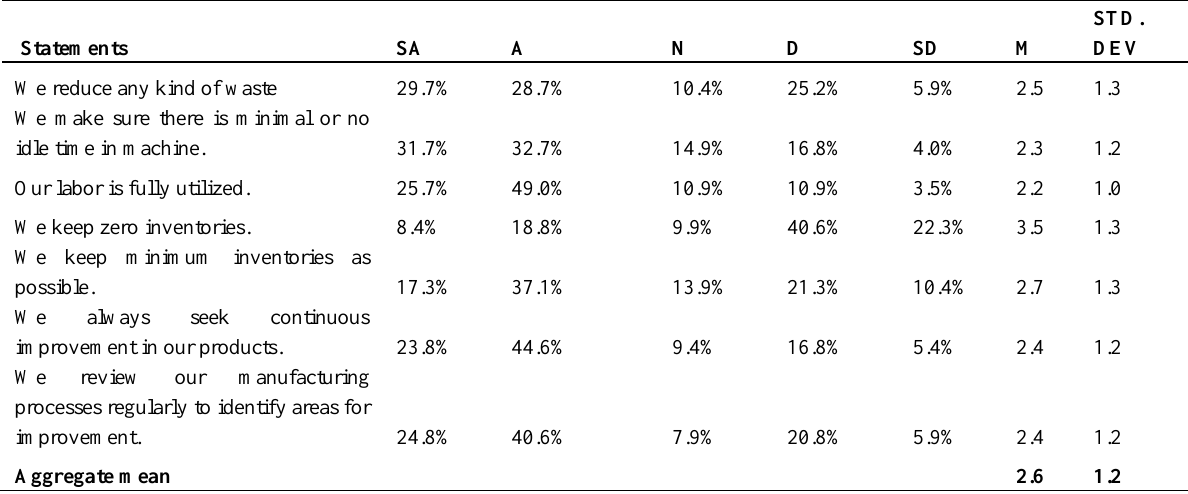
Table 1: Descriptive Statistics on Lean Supply Chain